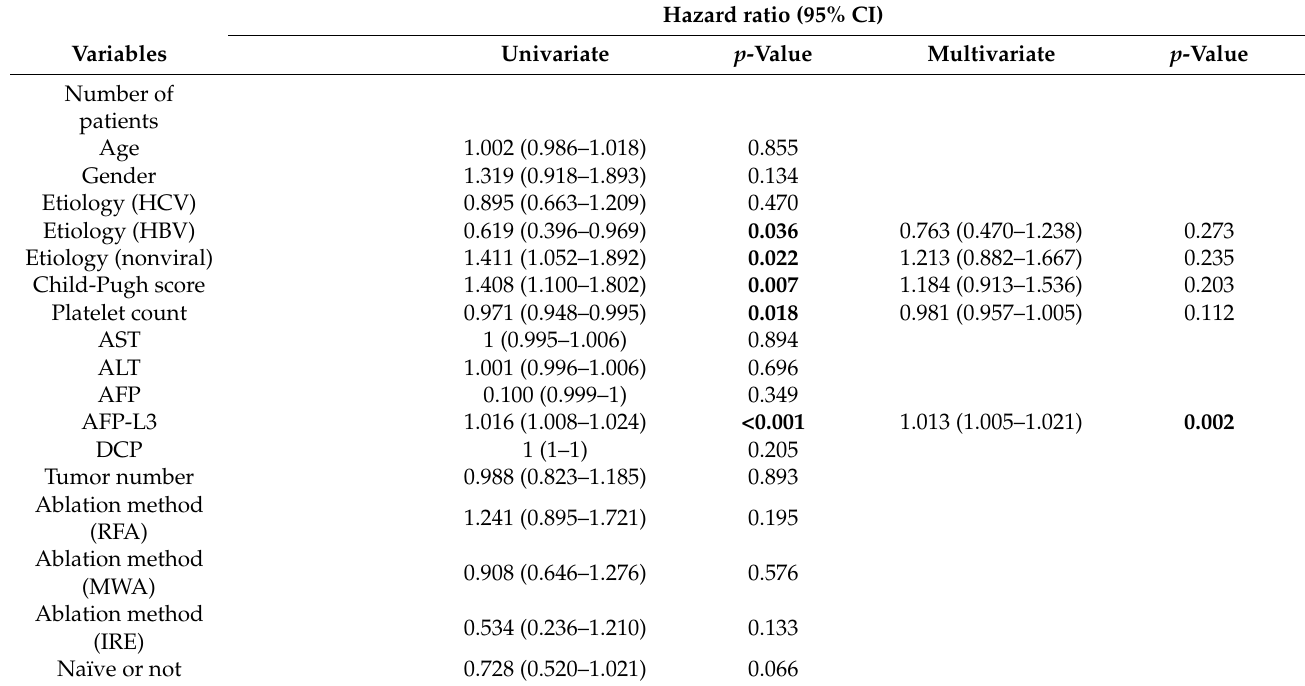
Table 6. Factors predisposing patients to recurrence of HCC after ablation.